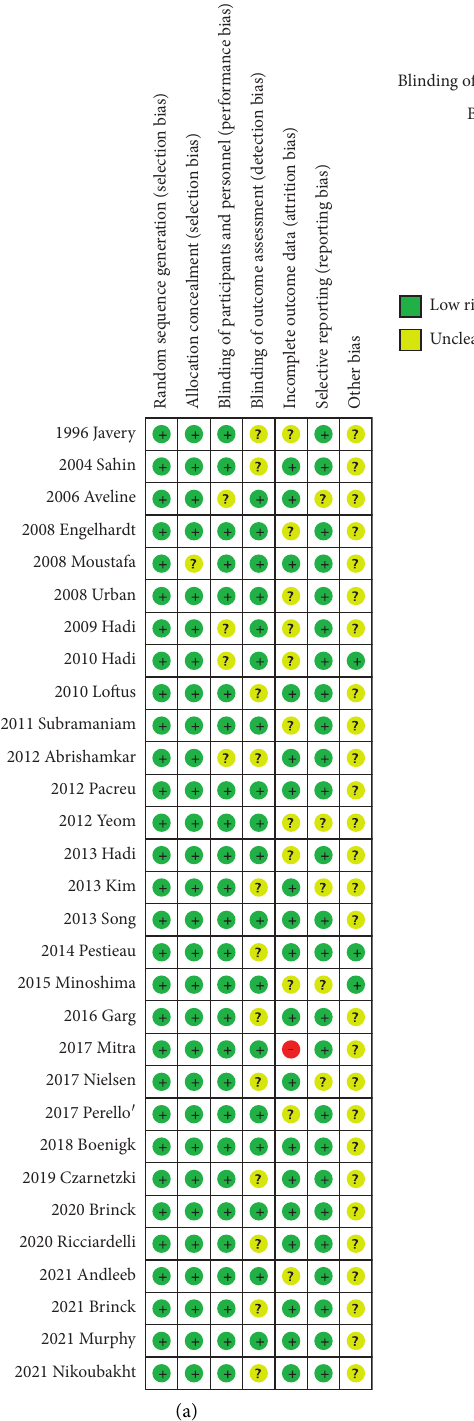
Figure 2: Risk of bias. (a) A summary table of each risk of bias item for each study; (b) a plot of the distribution of each risk of bias item. “+”: low risk of bias; “?”: unclear risk of bias; “–”: high risk of